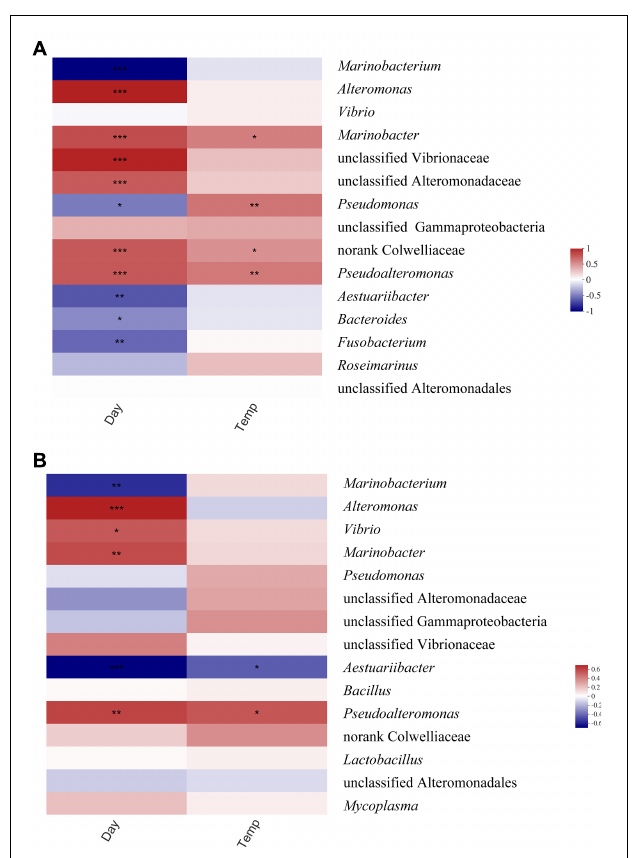
FIGURE 6 | Spearman’s rank correlation coefficients and the corresponding p -values (0.01 < p ≤ 0.05, **0.001 < p ≤ 0.01, *** p ≤ 0.001) were calculated based on correlation of the relative abundance of top 15 abundant taxa and different factors, such as cultivation time (days 4, 8, and 14) and temperatures (T20, T25, and T30) in (A) free-living and (B) attached